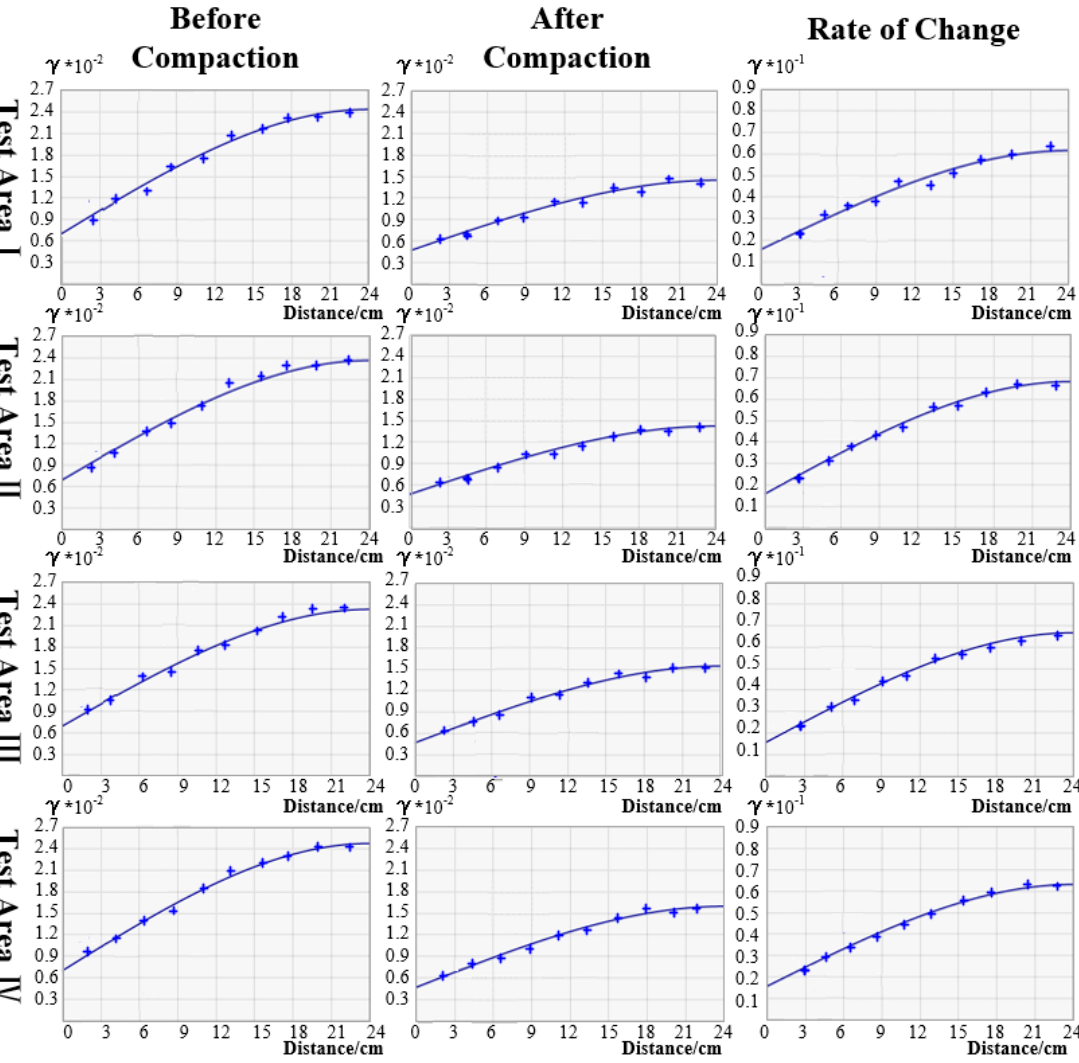
Figure 3. Longitudinal spatial semi − variance function of soil compactness in each test area.